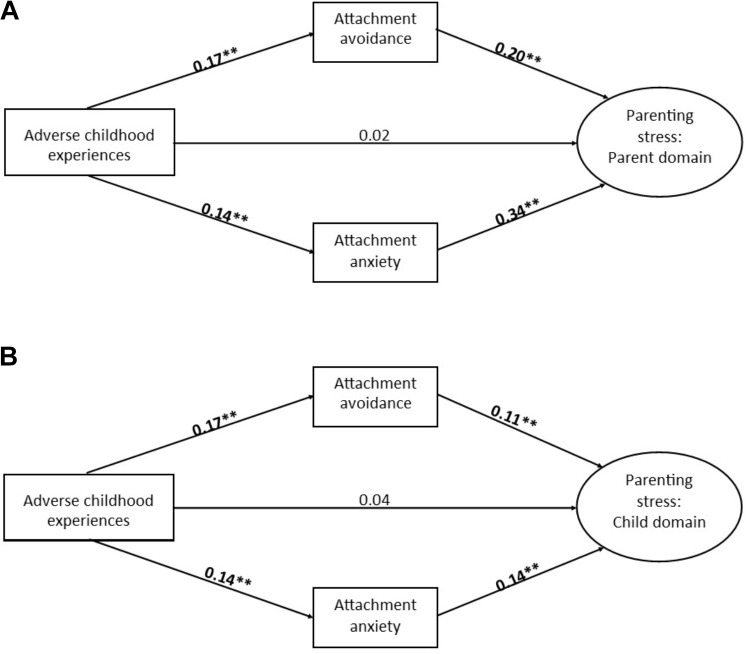
Graphical display of multiple mediation in a structural equation modeling framework. The dependent variable and mediators are controlled for all covariates. Squares indicate manifest variables and circles indicate latent factors. Standard errors were estimated by means of bootstrapping with 5,000 bootstrapping samples. Standardized coefficients are presented. Panel (A) shows results of mediation analyses with parenting stress – Parent Domain as outcome. The total effect from adverse childhood experiences on the Parent Domain was β = 0.10, p = 0.032. The indirect effect via attachment avoidance was β = 0.04, p < 0.001. The indirect effect via attachment anxiety was β = 0.05, p < 0.001. Panel (B) shows mediation analyses with parenting stress – Child Domain as outcome. The total effect of adverse childhood experiences on the Child Domain was β = 0.08, p = 0.040. The indirect effect via attachment avoidance was β = 0.02, p = 0.015. The indirect effect via attachment anxiety was β = 0.02, p = 0.007. ∗∗p < 0.01.